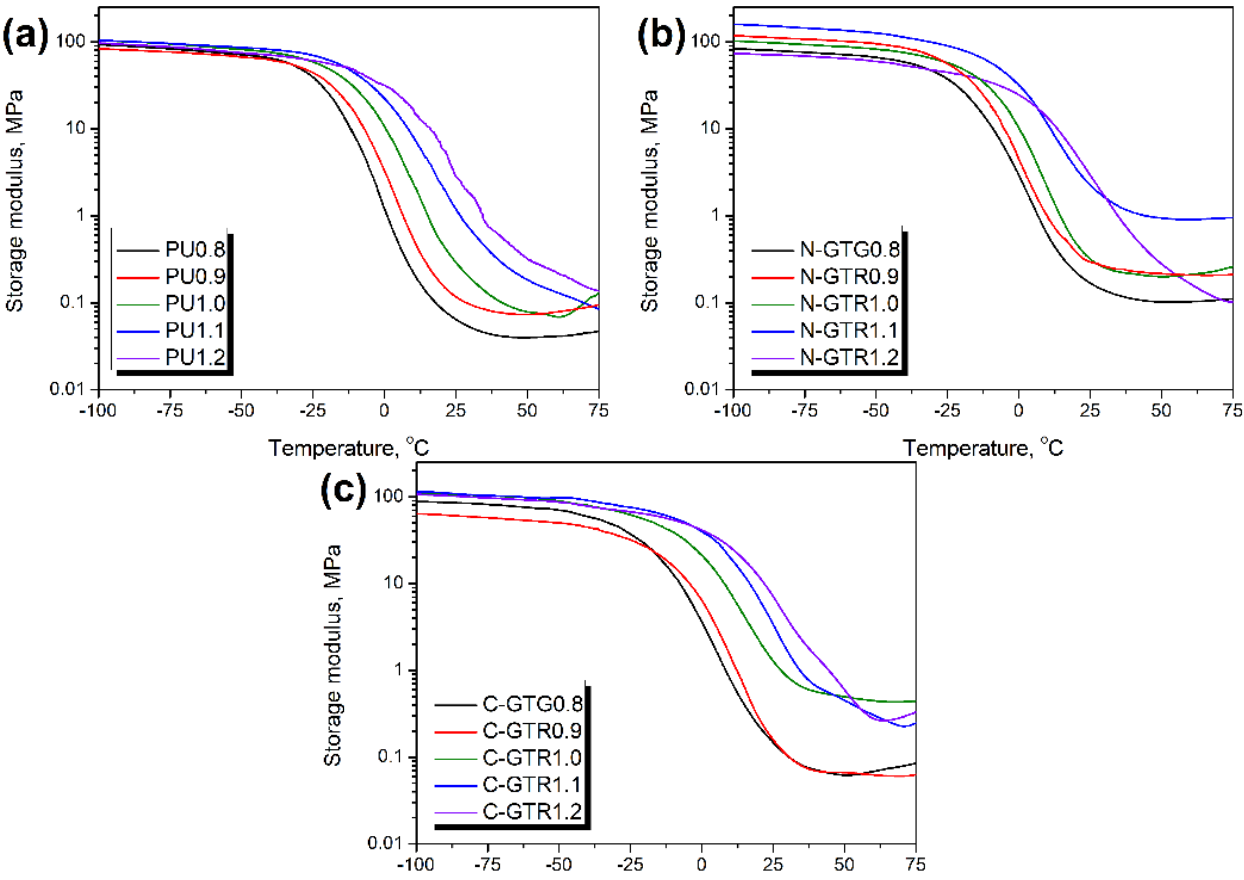
Figure 2. Temperature plots of storage modulus for ( a ) unfilled PU foams and PU/GTR composites pre- pared ( b ) without, and ( c ) with considering the hydroxyl values of GTR during formulation